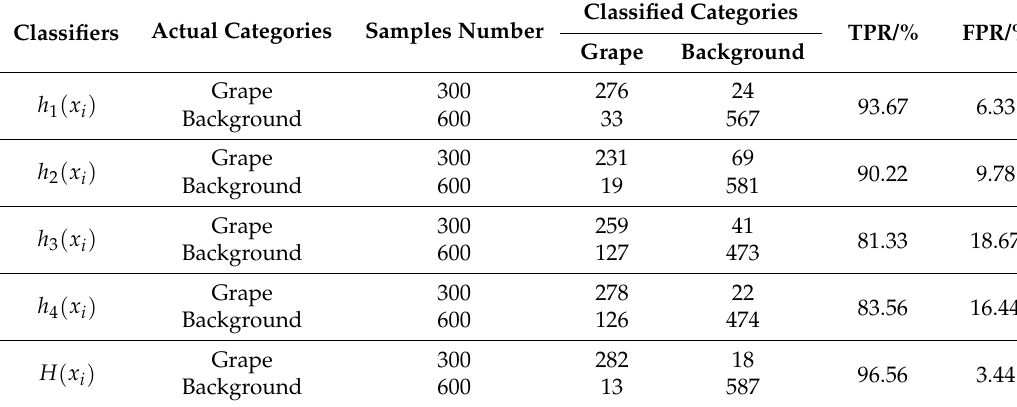
Table 2. Comparison of the classifiers accuracy.